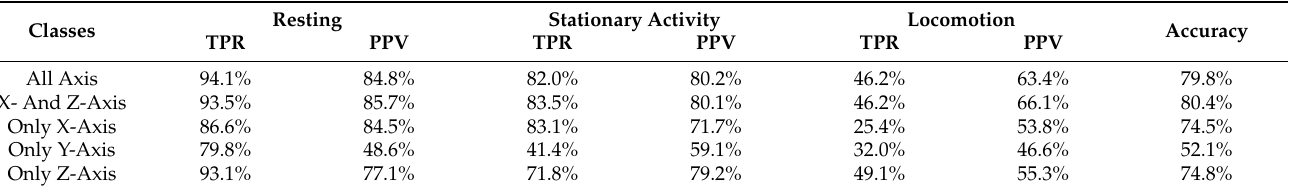
Table 2. This table shows the test results of five ensemble classification models. The models were trained using different sets of features which is described in the left most column. TPR stand for true positive rate and PPV for positive predictive